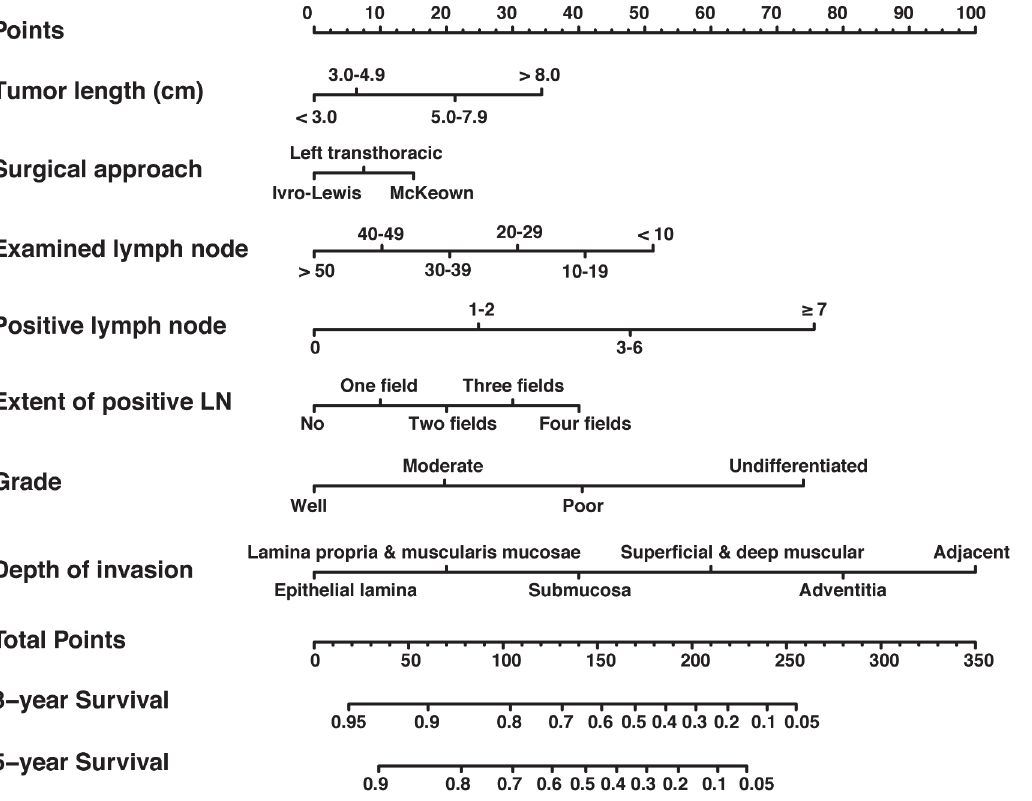
Fig 1. Nomogram for predicting 3-year and 5-year overall survival after radical esophagectomy for esophageal squamous-cell cancer. To calculate the survival rate of each individual patient, points for each of the factors were first identified on the uppermost point-scale, and then the total points from all factors were added up and projected on the bottom point-scale to indicate the probability of 3-year and 5-year survival. Abbreviation: LN, lymph nodes.